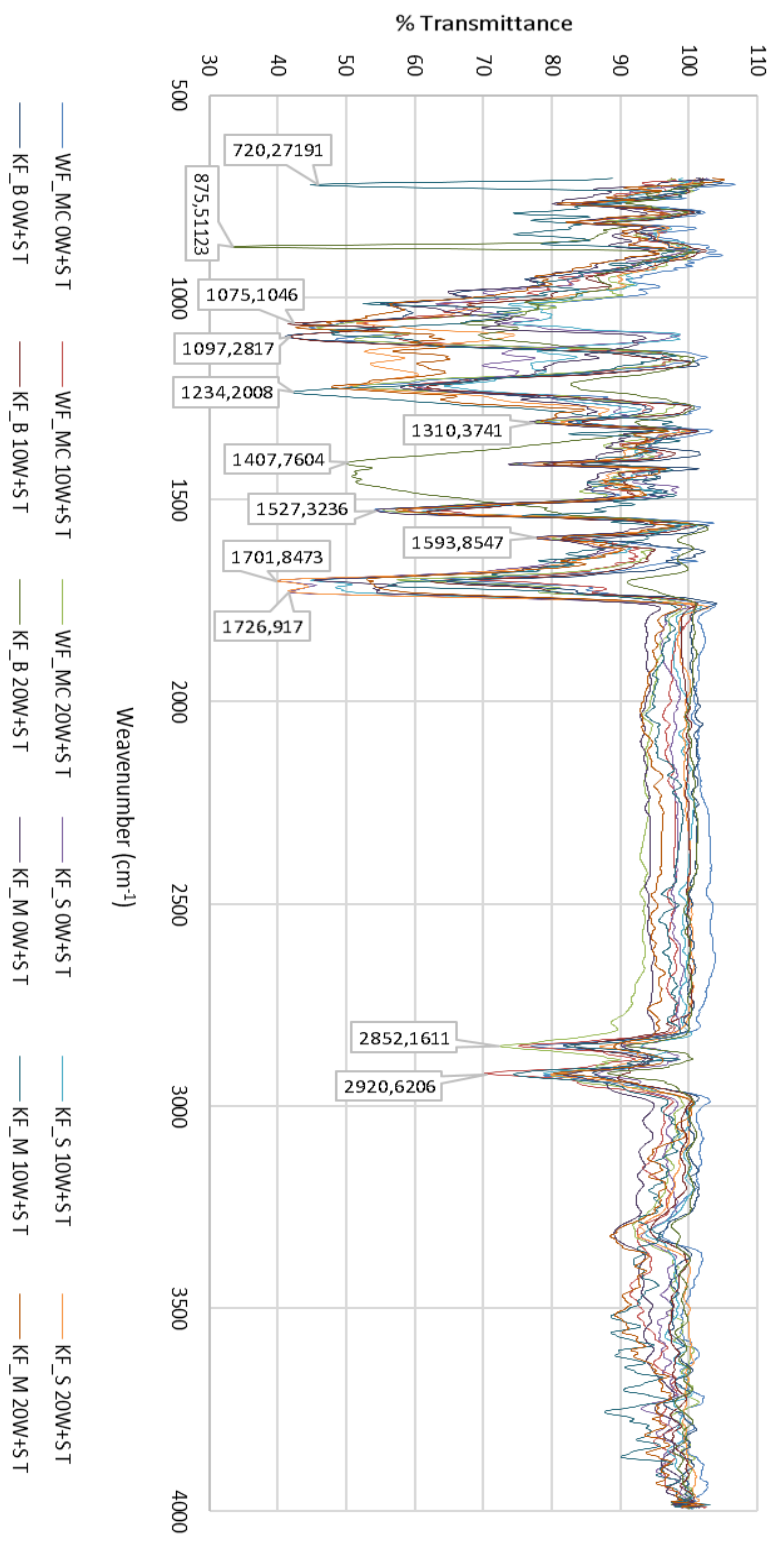
Figure 9. Entire FTIR spectrum of the PU coating of all samples: WF_MC, KF_S, KF_B, KF_M for 0 W+S, after 10 W+S and after 20 W+S.